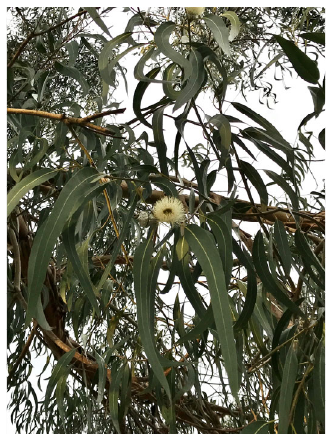
Figure 1. Eucalyptus globulus leaves.